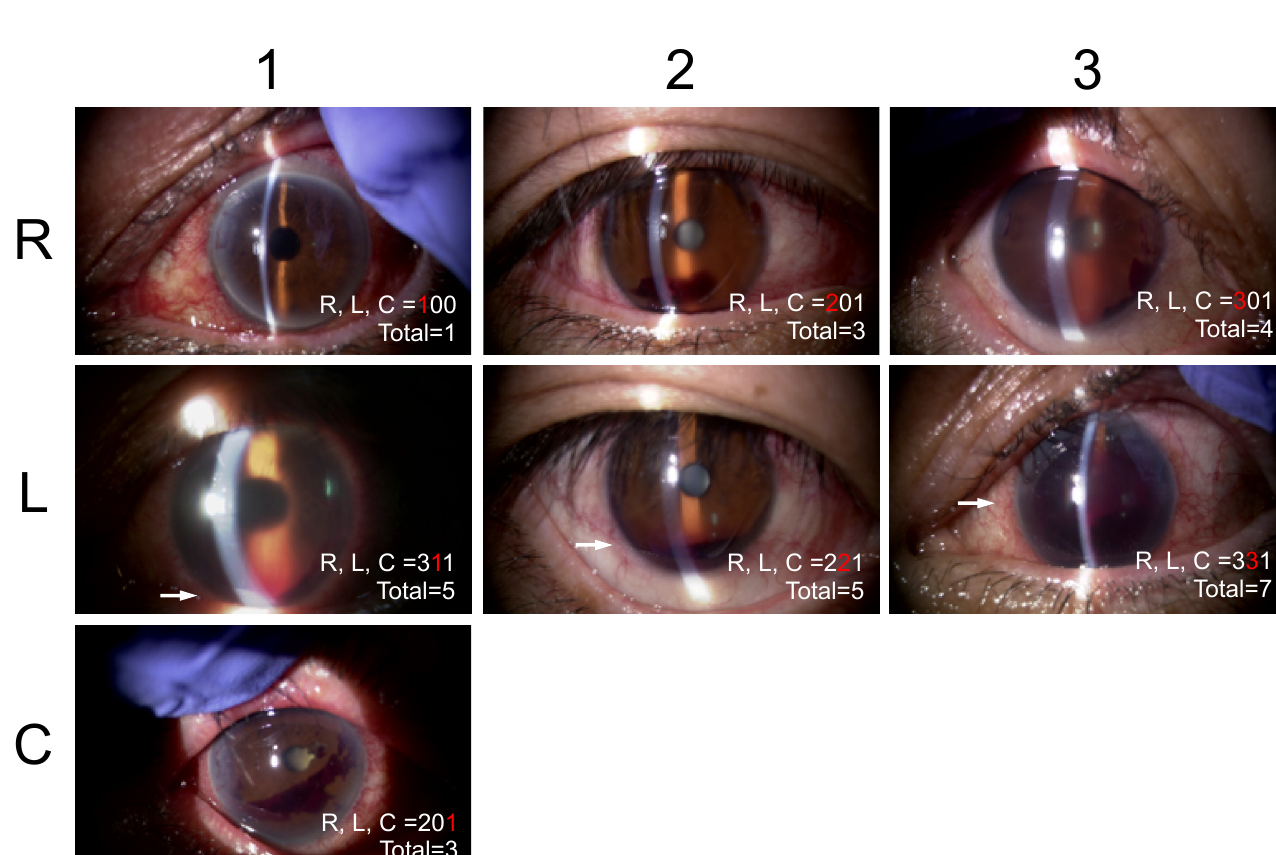
Figure 1. Representative anterior-segment photographs of each R, L, and C score. The Shimane University RLC postoperative hyphema scoring system can be expressed as a three-digit number when the clinicians record the hyphema severity in the medical chart. ( R ) Red blood cells score; ( L ) layer formation score; ( C ) blood clot score.